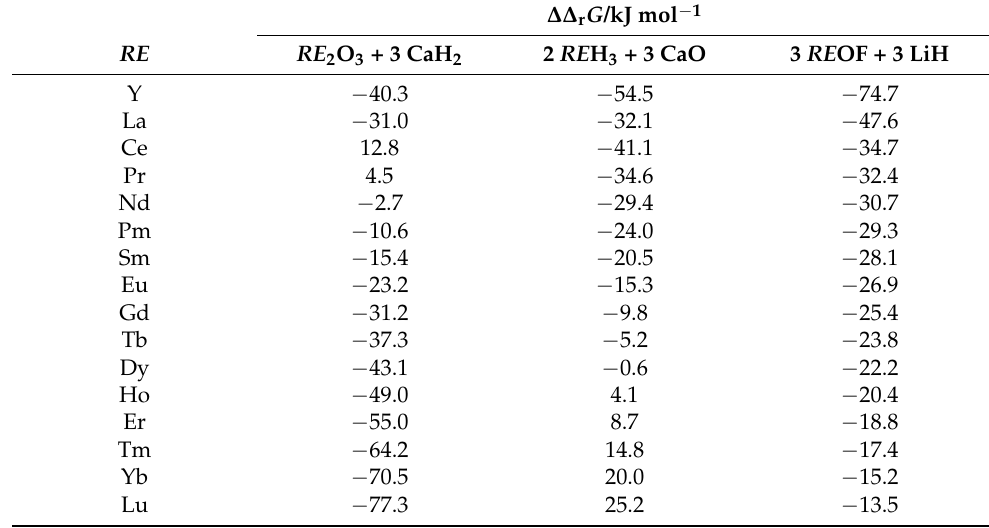
Table A7. Differences of free reaction enthalpies ∆∆ r G of three RE HO synthesis